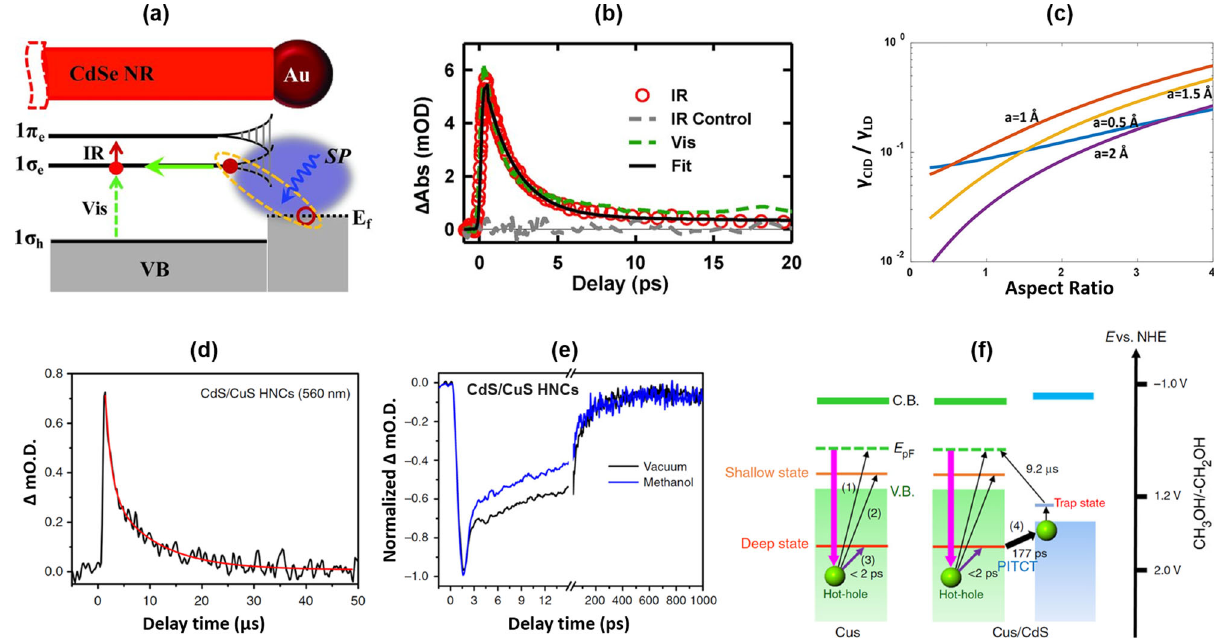
Fig. 7 Novel mechanisms to overcome charge recombination. a Schematic electronic energy diagram for strongly coupled Au-CdSe nanocomposite and direct plasmon-induced metal-to-semiconductor interfacial charge-transfer transition ( a , b from ref. 41 reprinted with permission from AAAS). b The intraband absorption feature (red circle) and 1 Σ -exciton-bleach (green dashed line) after excitation at 800 nm con fi rmed the presence of electrons in CdSe. The gray dashed line is a control for the mixture of CdSe NRs and Au nanoparticles. c Direct excitation of charge carriers into the adsorbate surface states. The ratio of chemical interface damping rates and Landau damping rates is a function of the aspect ratio of an ellipsoid nanoparticle (reprinted with permission from ref. 68 Copyright © 2021, American Chemical Society). d – f highlight a novel multistep PITCT mechanism resulting in long-lived charge separations. d Transient absorption for CdS/CuS HNCs tracking holes generated in the CdS phase where it gets trapped, leading to microsecond charge separation. e Transient absorption probing LSPR recovery rate: in CdS/CuS HNCs, the improved charge separation allows methanol to scavenge holes ef fi ciently, leading to a substantial increase in LSPR recovery. f Schematic of various decay pathways for hot holes generated in CuS NCs and CdS/CuS HNCs ( d – f reprinted from ref. 50